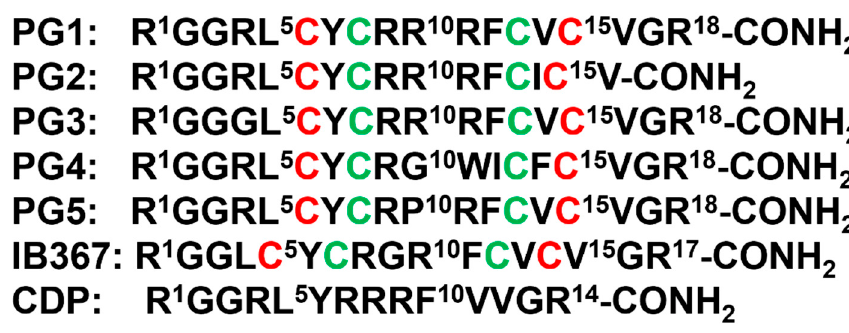
Figure 2. Amino acid sequence of protegrins and its derivatives. The disulfide bonds are formed between Cys6-Cys15 and Cys8-Cys13 residues, depicted by red and green color, respectively.